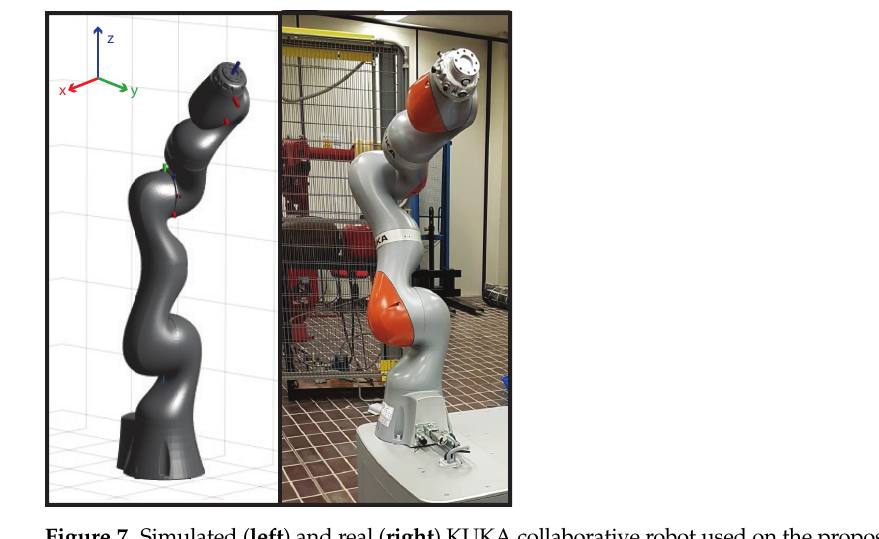
Figure 7. Simulated ( left ) and real ( right ) KUKA collaborative robot used on the proposed